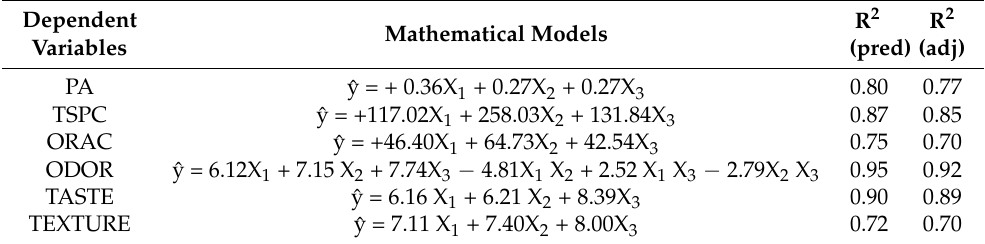
Table 3. Predictive regression models describing the relationships between the nutritional attributes of the breads and flour blend composition.